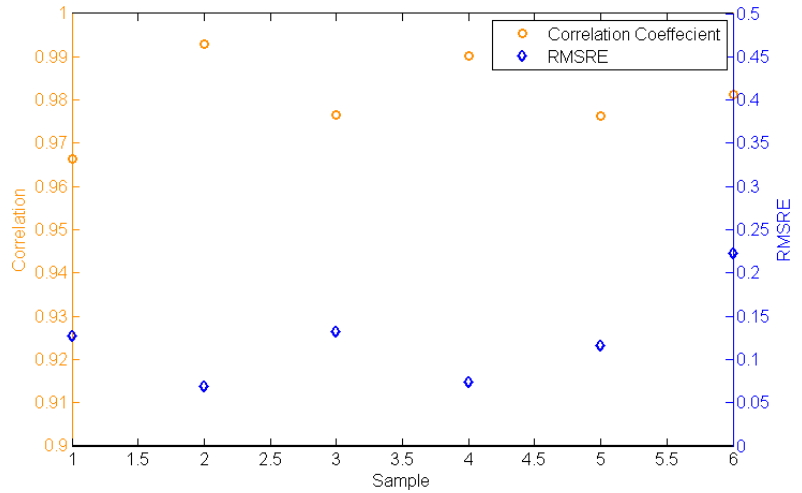
Figure 15. The comparison of reflectance.